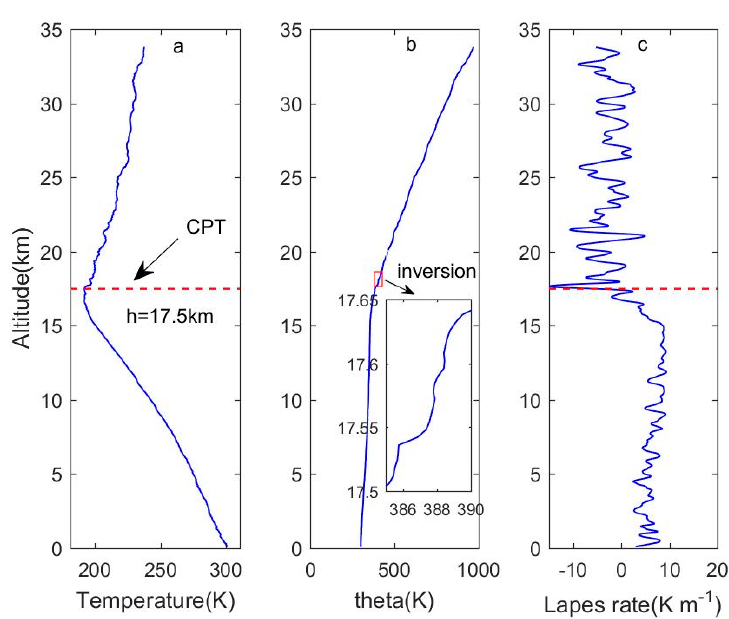
Figure 1. ( a ) The temperature profile (the red dotted line indicates the cold point tropopause (CPT), and the height is 17.5 km). ( b ) The potential temperature profile, where the profile in the red box is enlarged to observe the inversion areas. ( c ) Temperature lapse rate at 12 UT on 31 May 2018.